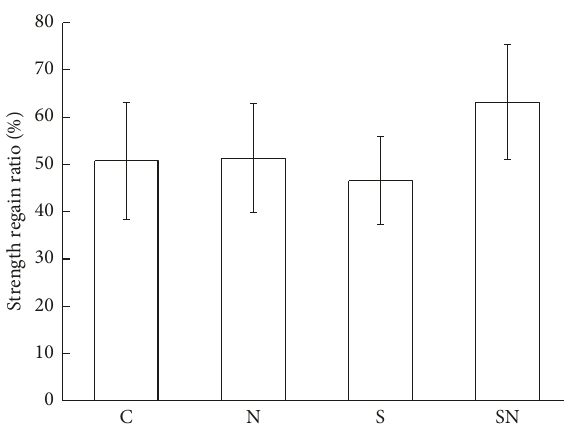
Figure 6: The regain ratio of the compressive strength by self- healing.